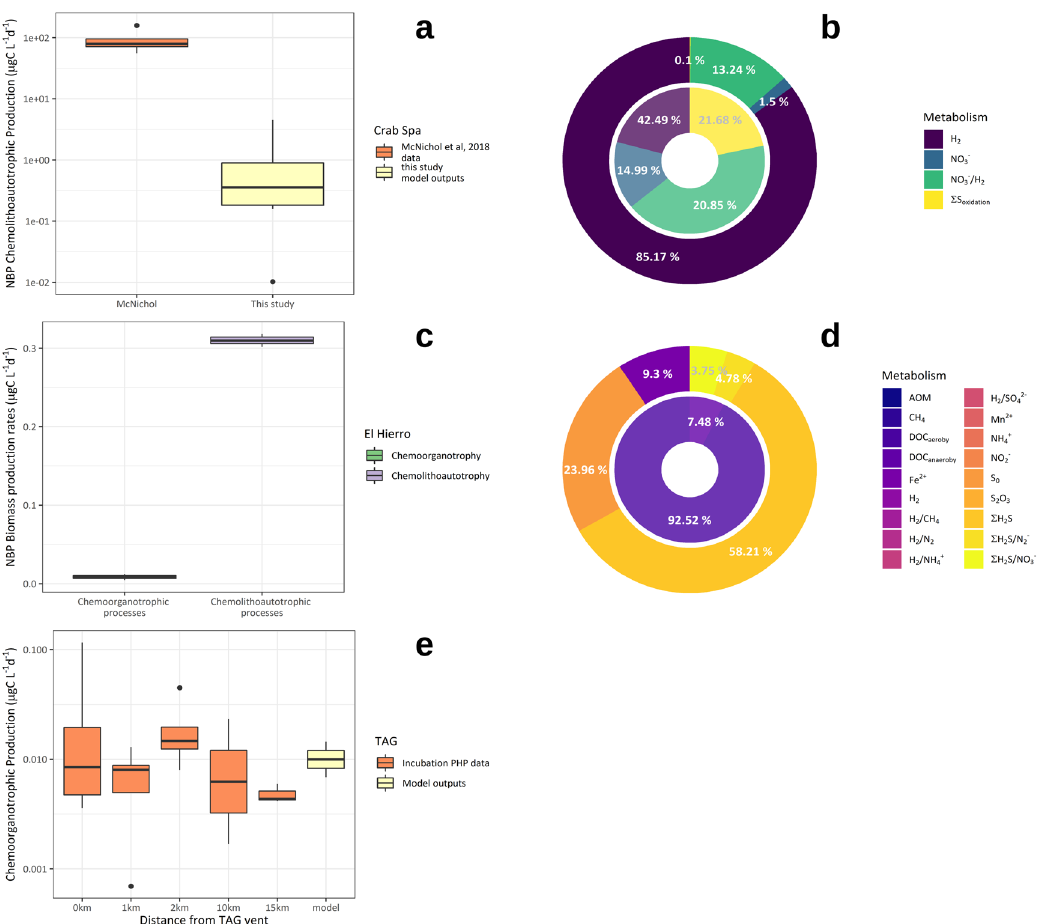
Fig. 1 Chemolithoautotrophic and chemoorganotrophic biomass production rates in hydrothermal non-buoyant plumes: model outputs and measurements. a Chemolithoautotrophic biomass production rates from the CrabSpa vent fi eld: comparison between NBP model outputs and fl uid incubation data from ref. 14 . b Distribution of the type of metabolisms responsible for the primary production at the CrabSpa vent fi eld: comparison between NBP model outputs and fl uid incubation data from ref. 14 . c Chemoorganotrophic and chemolithautotrophic biomass production predicted for the El Hierro eruption based on data from ref. 44 . d Distribution of the type of metabolisms responsible for the chemoorganotrophic and chemolithoautotrophic biomass production predicted for the El Hierro eruption based on data from ref. 44 . e Chemoorganotrophic biomass production rates within the TAG vent non-buoyant plume: comparison between model outputs and data derived from 3 H-Leucine incorporations (conventionally designed as prokaryotic heterotrophic production, PHP) rates on incubations performed during the BICOSE 2 cruise. Boxplots denote the median (center line) and interquartile range (box), with whiskers extending to three times the interquartile range and points indicating values outside this